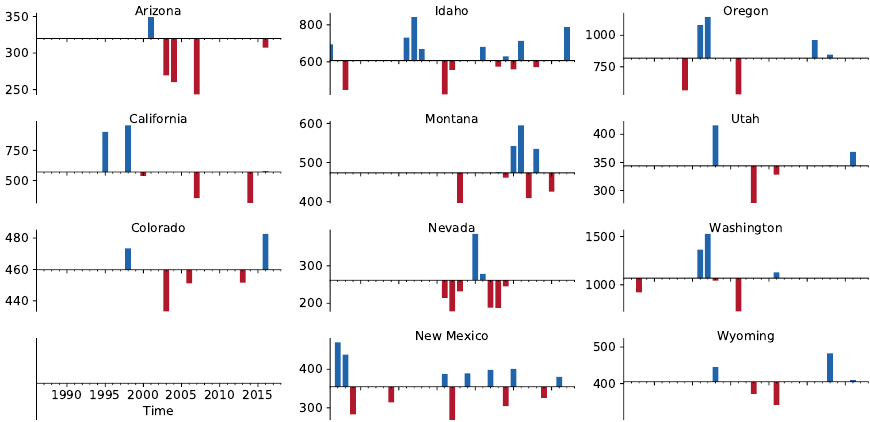
Figure 4. Precipitation during the years irrigation was verified for IrrMapper in millimeters; the bar height shows difference from mean statewide precipitation (i.e., the horizontal axis). Precipitation normals are the 100-year statewide average precipitation (1901–2000) during the 12 months ending in September of the year specified. All subplots range 1986–2018, as shown in lower